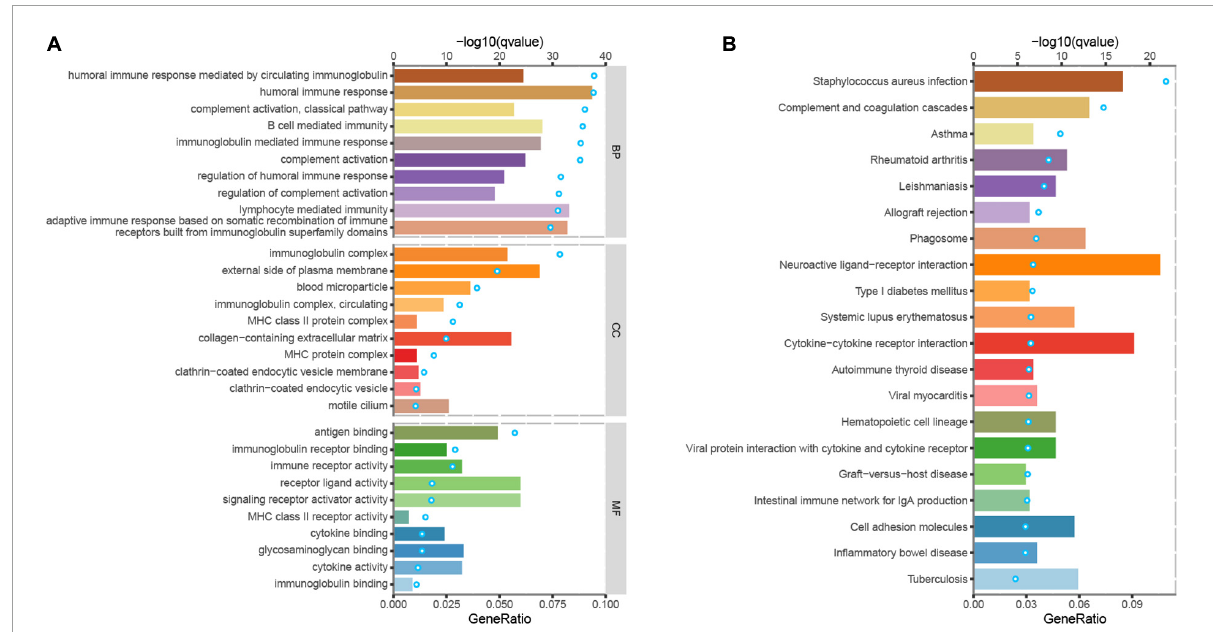
FIGURE4 Gene ontology (GO) and kyoto encyclopedia of genes and genomes (KEGG) analyses of DEGs between PSENEN high expression and low expression groups in LGG. (A) Top 10 BP, CC, and MF enrichment terms of DEGs. (B) Top 20 KEGG enrichment pathways of DEGs. The blue dots represent the q -values of the upper axis enrichment pathways, and the horizontal bars correspond to the gene ratio in the lower axis enrichment